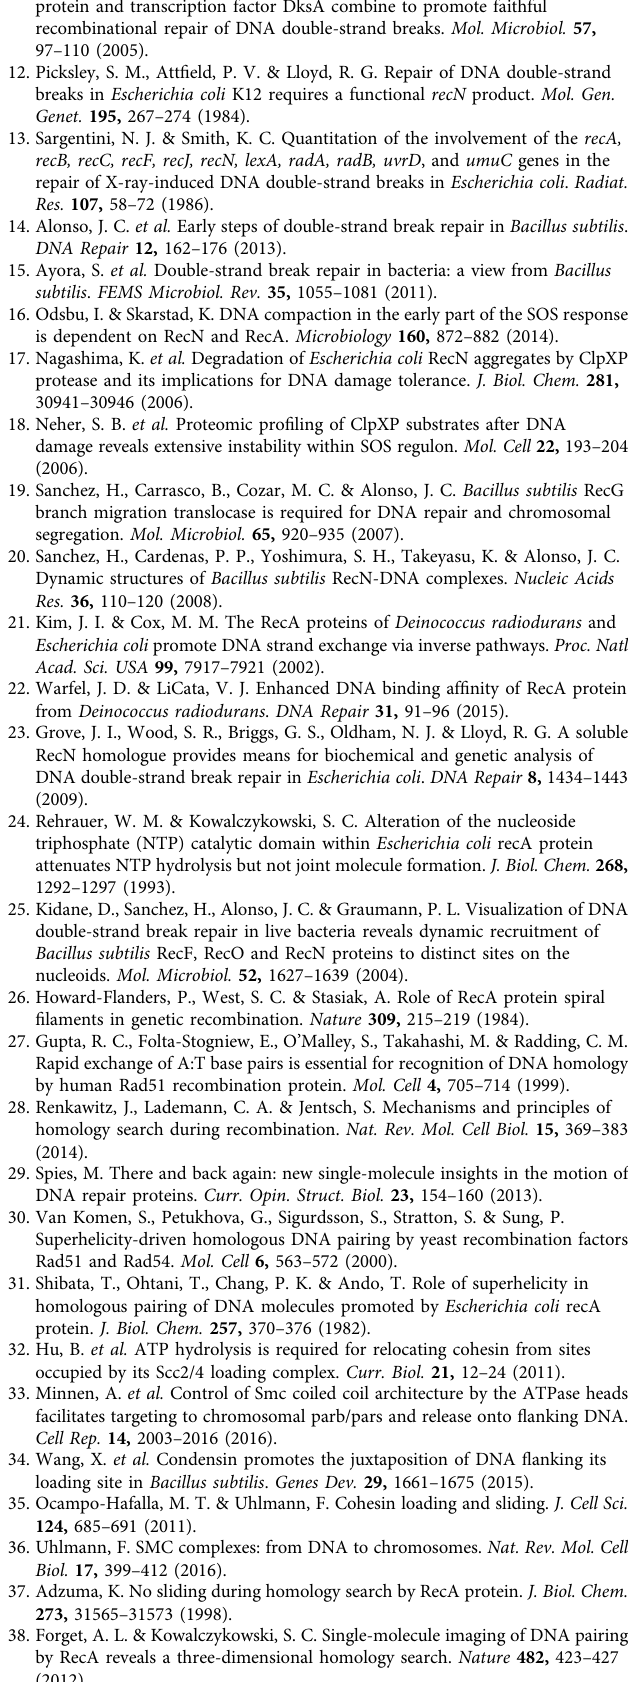
(Fig. 1b) were stopped by adding 2 (cid:3) loading stop buffer and proteinase K (to 1.25mgml (cid:2) 1 ). Samples were subjected to electrophoresis in 0.8% agarose gels with TBE buffer, stained with ethidium bromide and exposed to ultraviolet light. The inverted gel images were obtained using a digital charge-coupled device camera with Foto/Analyst PC Image software version 10.21